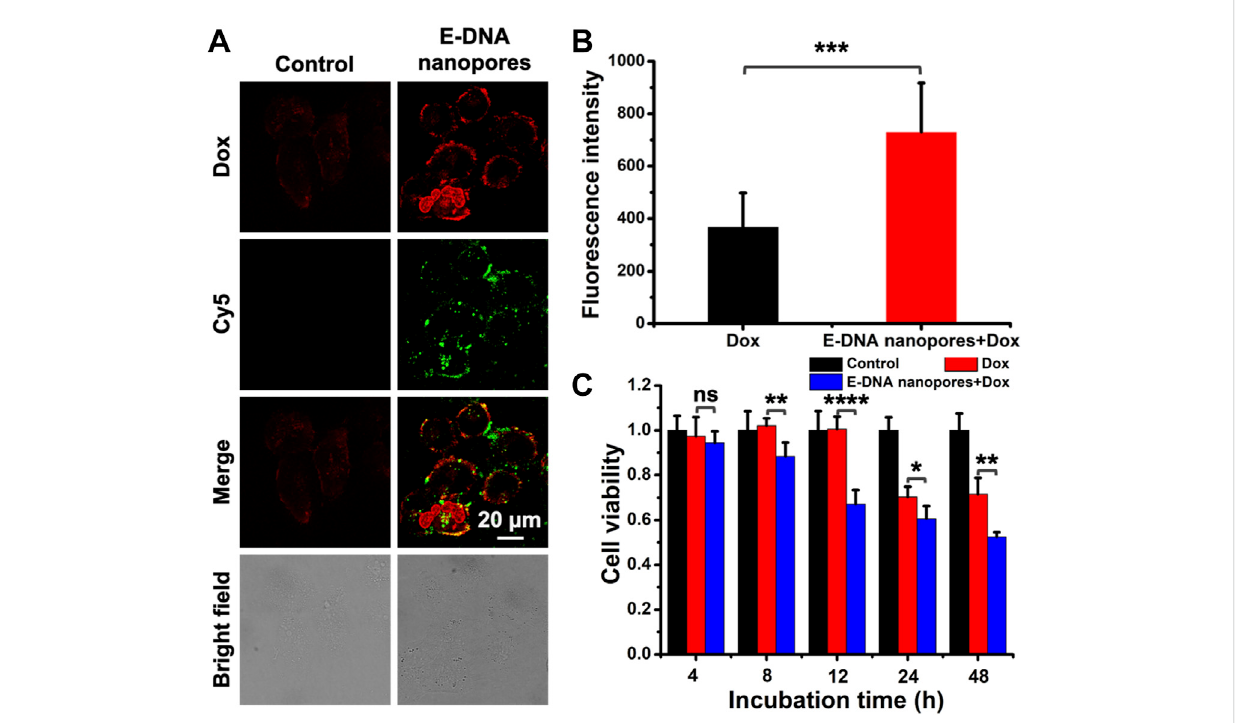
FIGURE 6 (A) Confocal images of MCF-7/Adr cells inserted with DNA nanopores and incubated with Dox at 37 ° C for 2 h. Scale bar: 20 μ m. (B) The statistic of average fl uorescence intensity of Dox in each MCF-7/Adr cell ( n = 20). *** indicates p < 0.001. (C) Cell viability of MCF-7 cells incubated with 0.15 mg/ml Dox at 37 ° C for 2 h and then incubated at 37 ° C for different time without extra Dox ( n = 5). ns indicates no signi fi cant difference. * indicates p < 0.05. ** indicates p < 0.01. **** indicates p <